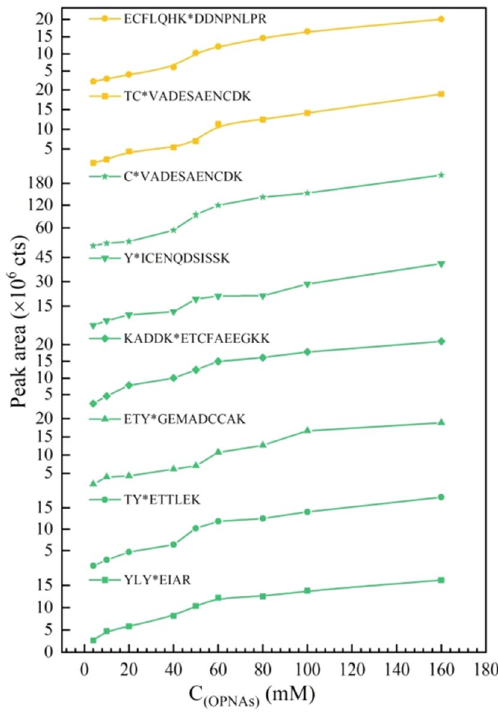
Figure 4. Peak area of peptides modified by V-type OPNAs with gradient concentration. C (OPNAs) represents the final concentration in the solution system. Peptides Y*ICENQDSISSK, TY*ETTLEK, YLY*EIAR,